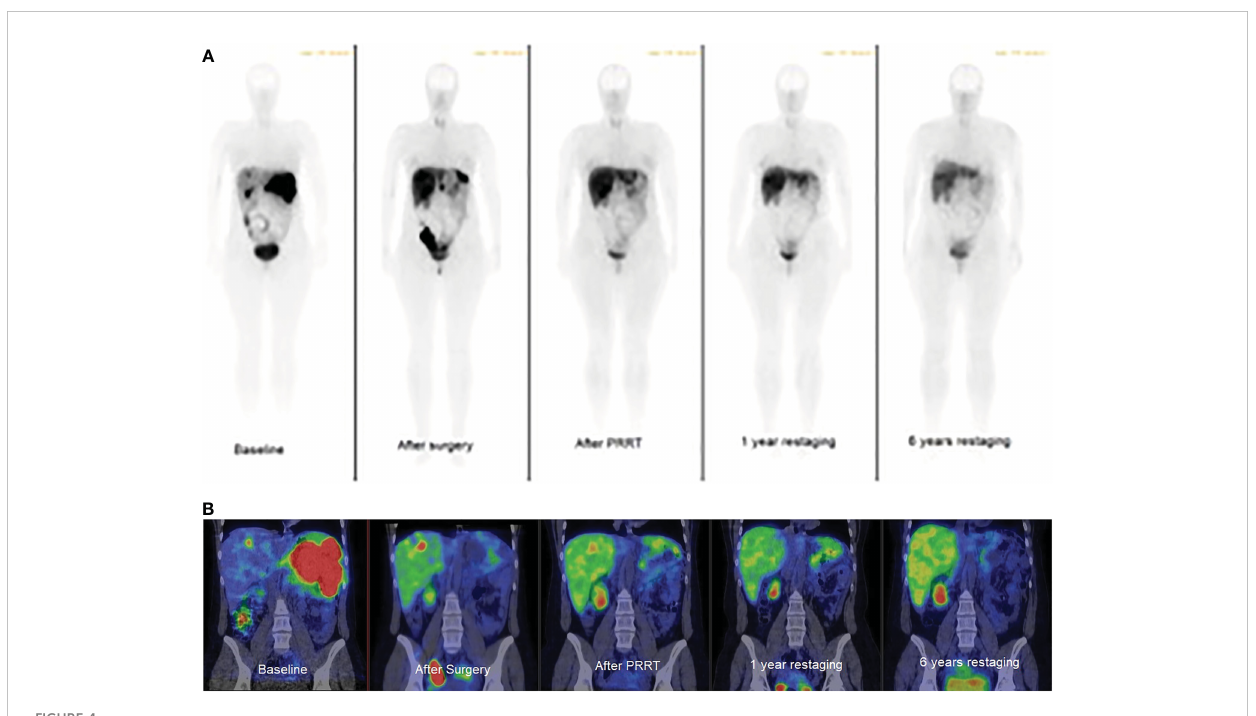
FIGURE 4 Whole-body somatostatin receptor imaging. (A) : planar gamma camera images, anterior view, (B) : abdominal SPECT/CT images, coronal view. Baseline: multiple spleen and focal liver metastases. After surgery: focal liver and peritoneal oligometastases. After PRRT: focal liver metastasis. 1 year restaging: focal liver metastasis, 6 years restaging: no visible metastasis. Metastases are black on planar and red on SPECT/CT images.